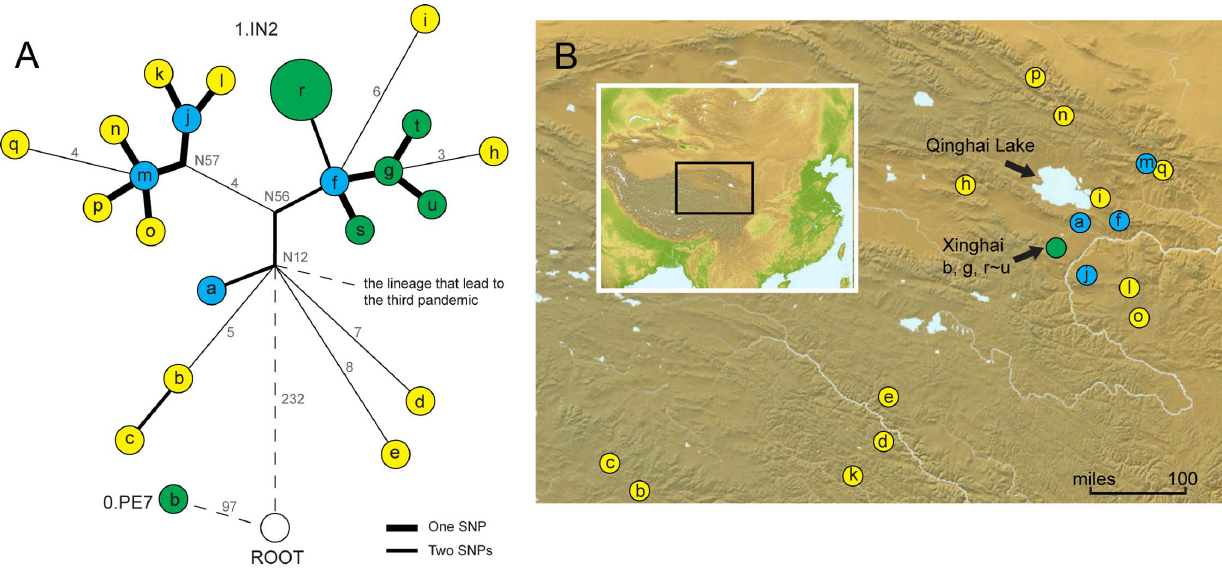
Figure 3. Second step of source tracing: Investigating the phylogenetic relationship within the particular phylogroup and historical isolates in the outbreak region. (A) MSTree of strains in the phylogroup 1.IN2 (a to q), 2009 outbreak strains (r), and historical strains in Xinghai County (s, t, u, and 0.PE7b). The circle size represents the number of strains it contains. The designation of hypothetical nodes was obtained from previous research [32], and the SNP numbers ( . 2) between the nodes are labeled in gray on each branch. Strains that were close to the MRCA of phylogroup 1.IN2 (node N12) are marked in blue, strains isolated from Xinghai are in green, and the other strains are in yellow. (B) Geographic distribution of strains used in